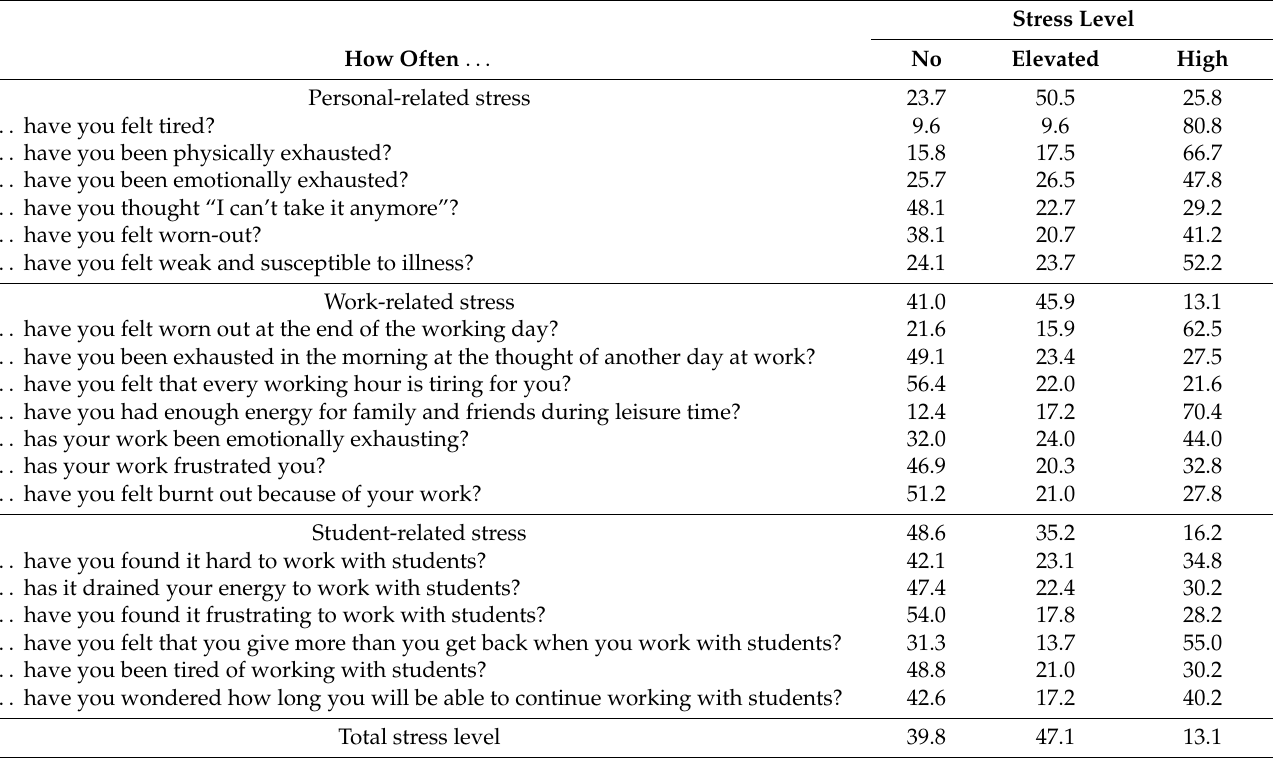
Table 2. Teachers stress level (%).